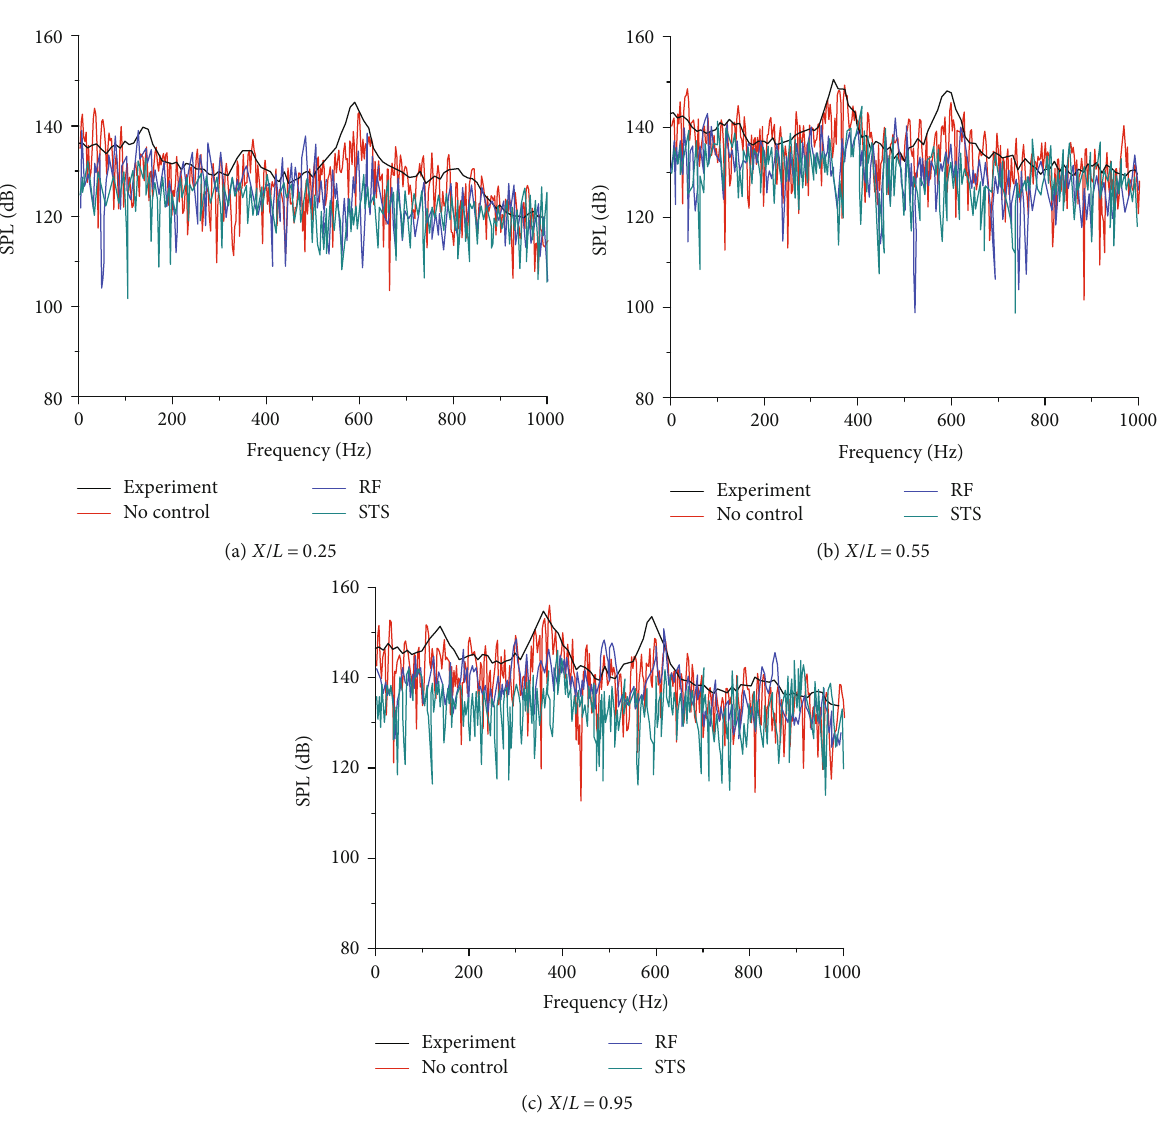
Figure 14: Sound pressure frequency spectra.